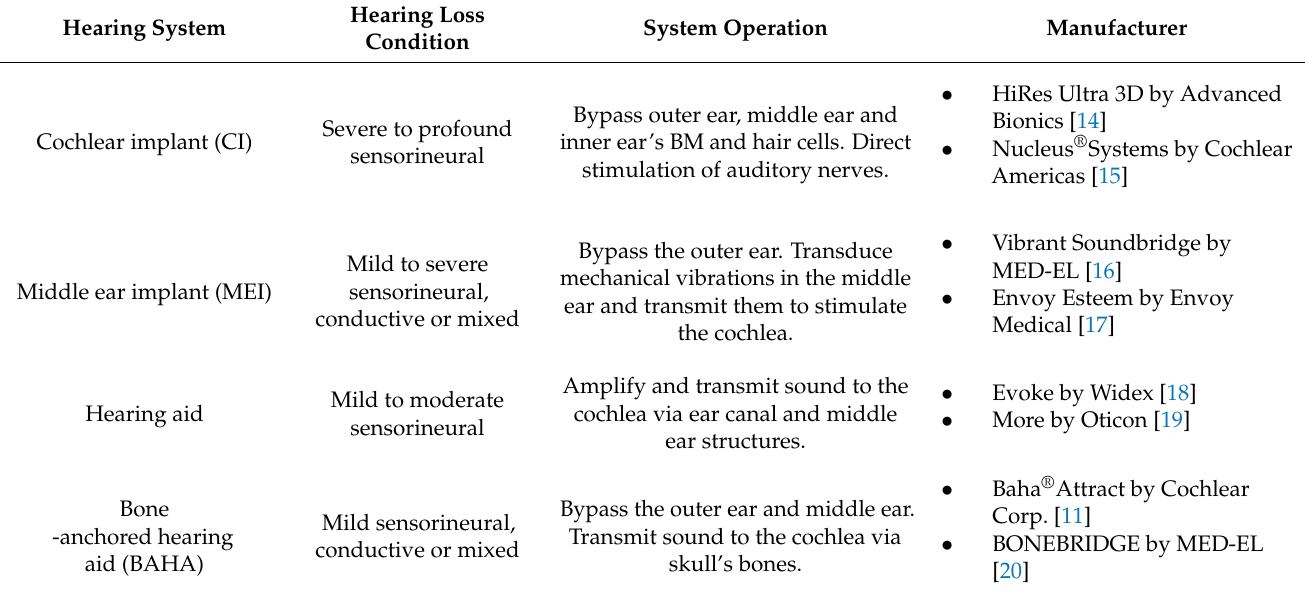
Table 1. Descriptions of the commercially available hearing